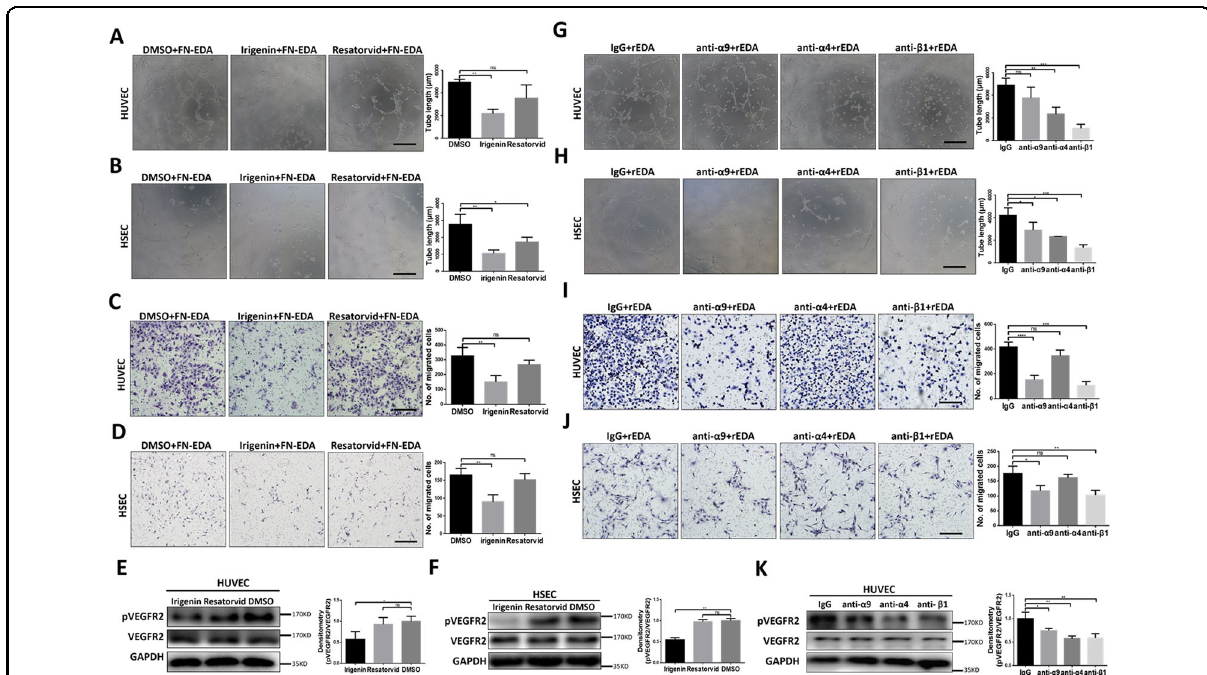
Fig. 4 FN-EDA promoted angiogenesis through Integrins. A , B Tube formation assay of HUVECs and HSECs treated with Irigenin or Resatorvid (5 μ M) along with FN-EDA (40 μ g/ml) for 6 h ( n = 3). (Data are shown as mean ± SEM; HUVEC: Irigenin versus Ctrl: ** P < 0.001; Resatorvid versus Ctrl: ns. HSEC, Irigenin versus Ctrl: ** P < 0.001; Resatorvid versus Ctrl: * P < 0.01; scale bar = 100 μ m.) C , D Migration assay of HUVECs and HSECs treated